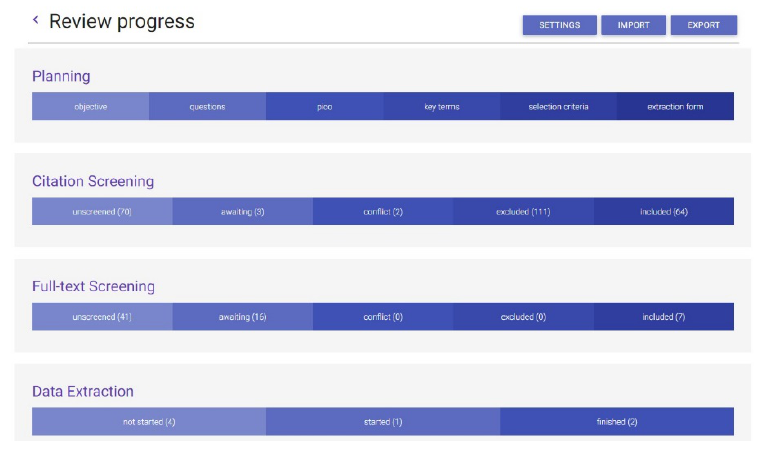
Figure 2 Data extraction form with PDF